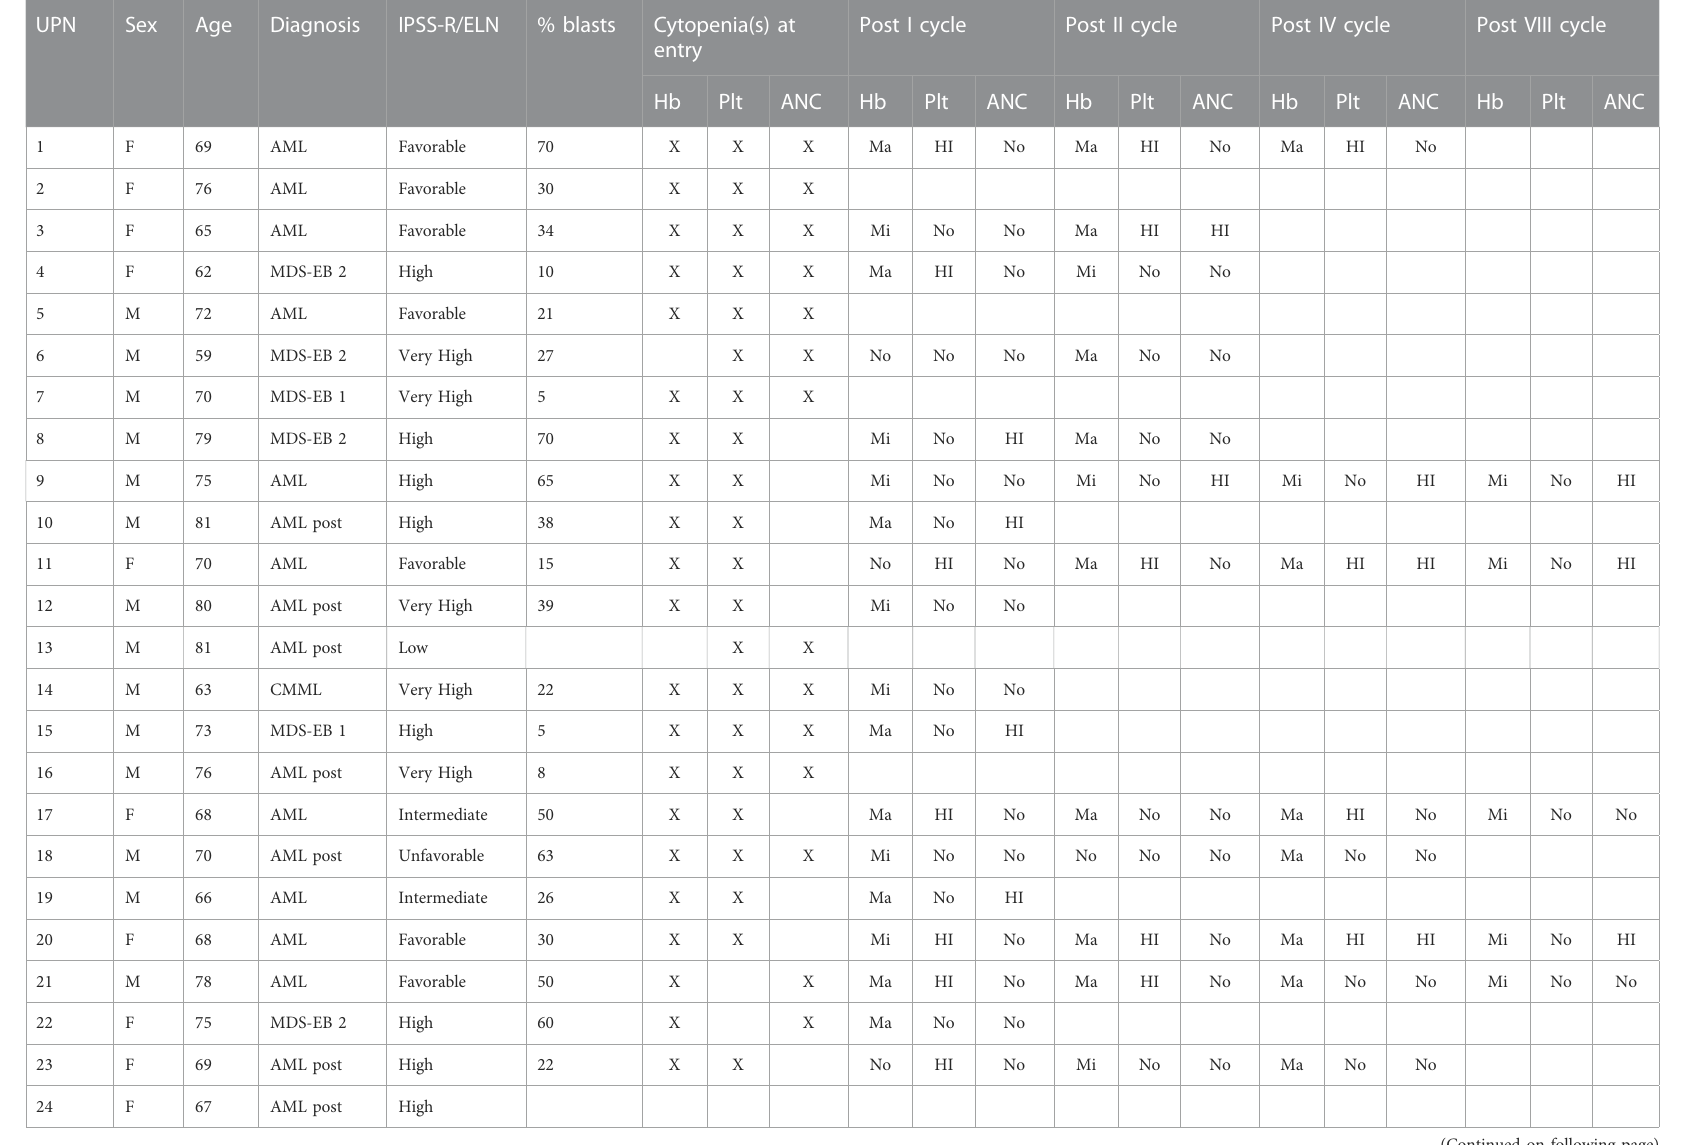
TABLE 2 Hematologic improvements to azacytidine plus venetoclax.